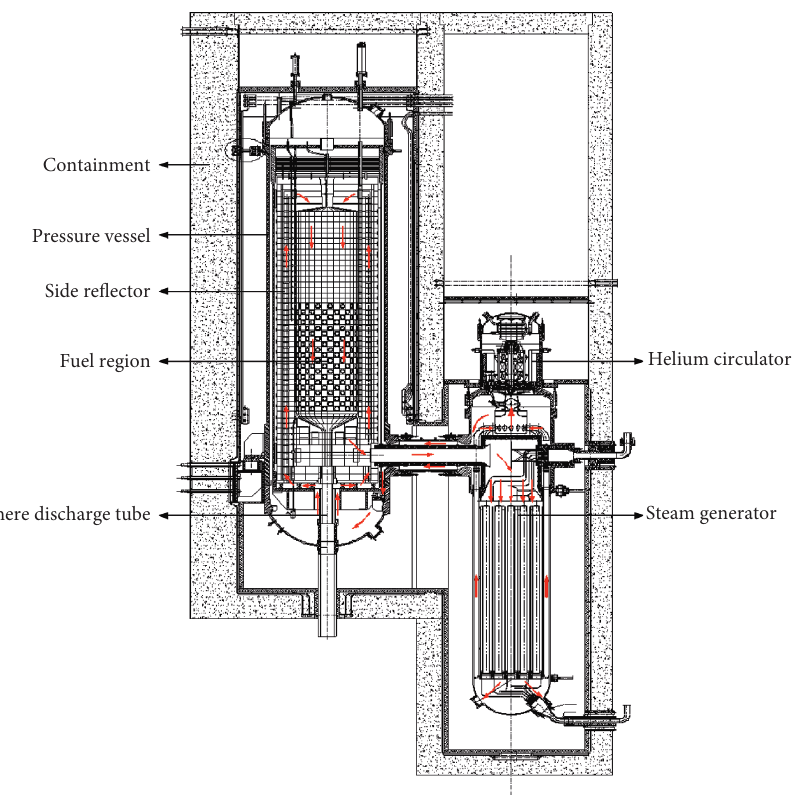
Figure 1: Cross section of the